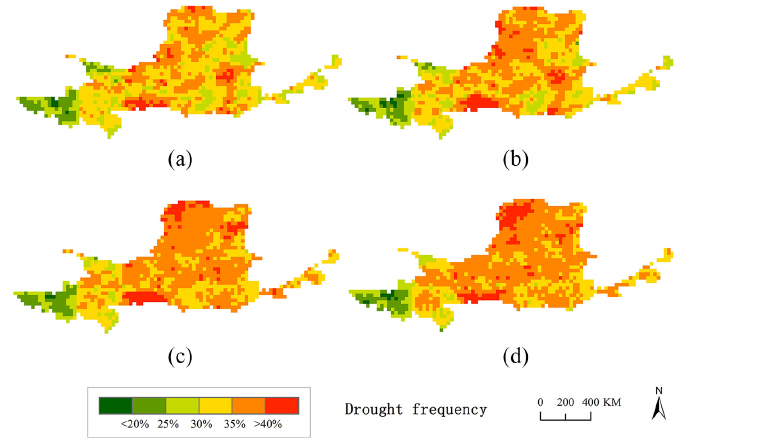
Figure 6. The spatial distribution characteristics of